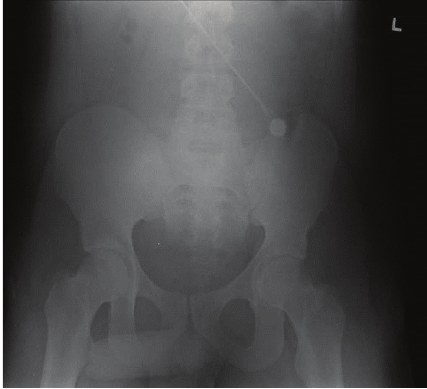
Figure 2: Pelvic X-ray did not reveal any fracture or radiopaque foreign body.